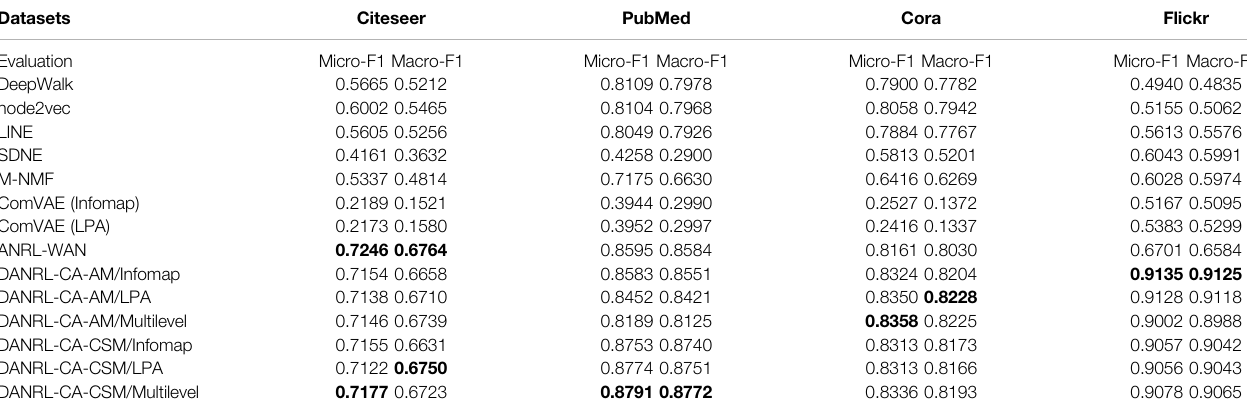
TABLE 9 | Node classi fi cation results on Citeseer, Pubmed, Cora, BlogCatalog and Flickr datasets. Datasets Evaluation